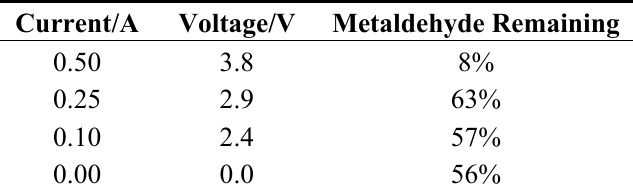
Table 1. Typical voltages observed at fixed applied current for regeneration and % metaldehyde remaining after five cycles,